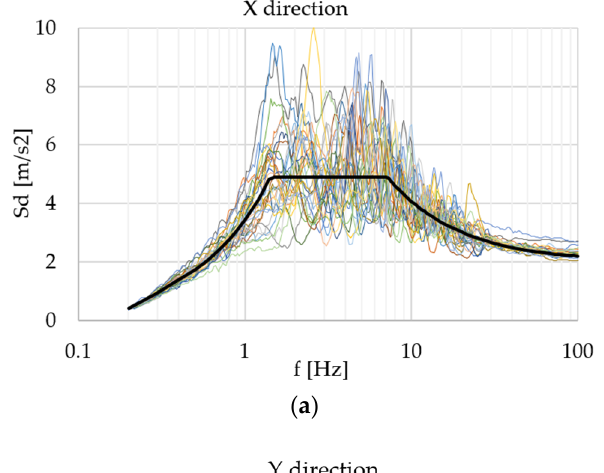
( b ) Figure 11. Example of generated time histories using ( a ) Method 1 and ( b ) Method 2. For the current study, Method 2 was used, as it produces much more realistic accel-